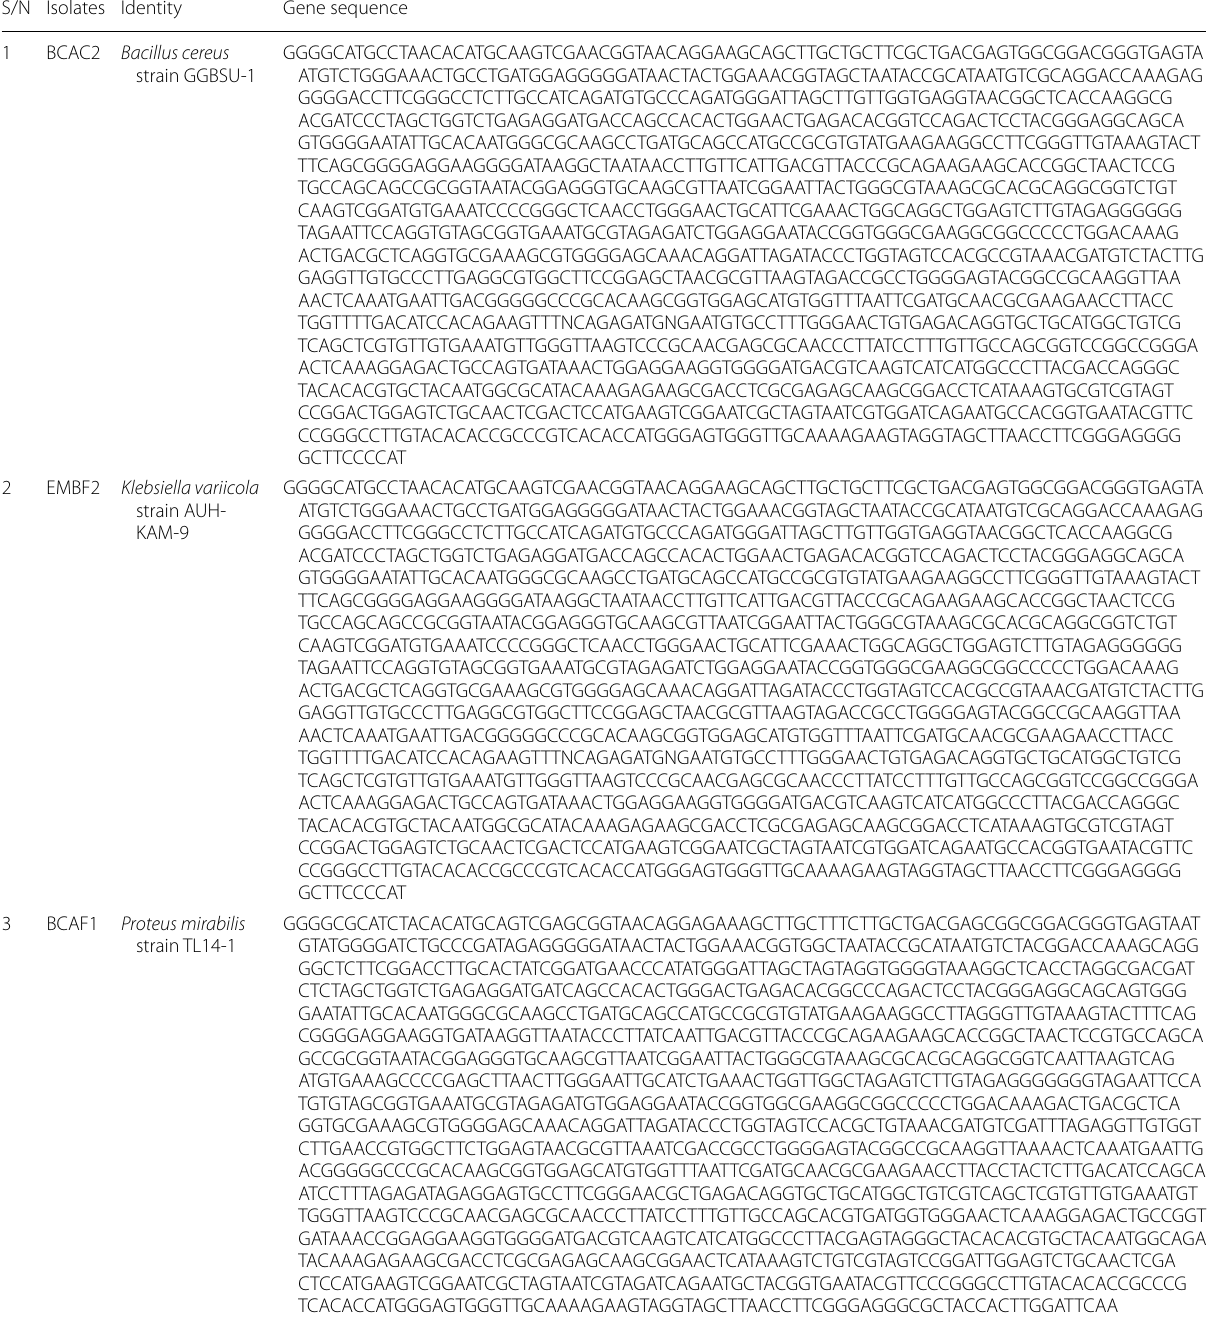
Table 1. Gene sequence of isolates S/N Isolates Identity Gene sequence